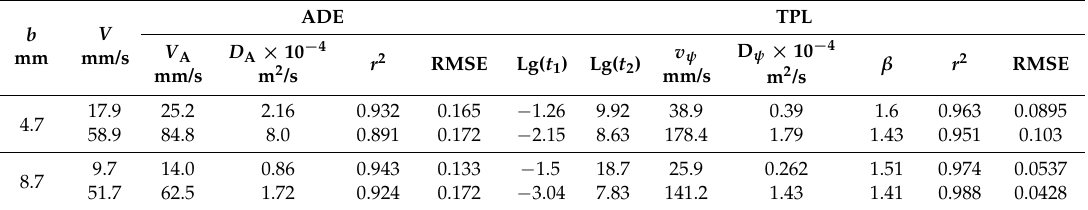
Figure 10. BTCs and fitting results in single fractures with rectangular rough fractures ( x = 555 mm). Table 7. Fitting parameters of BTC in single fractures with smooth parallel plates.